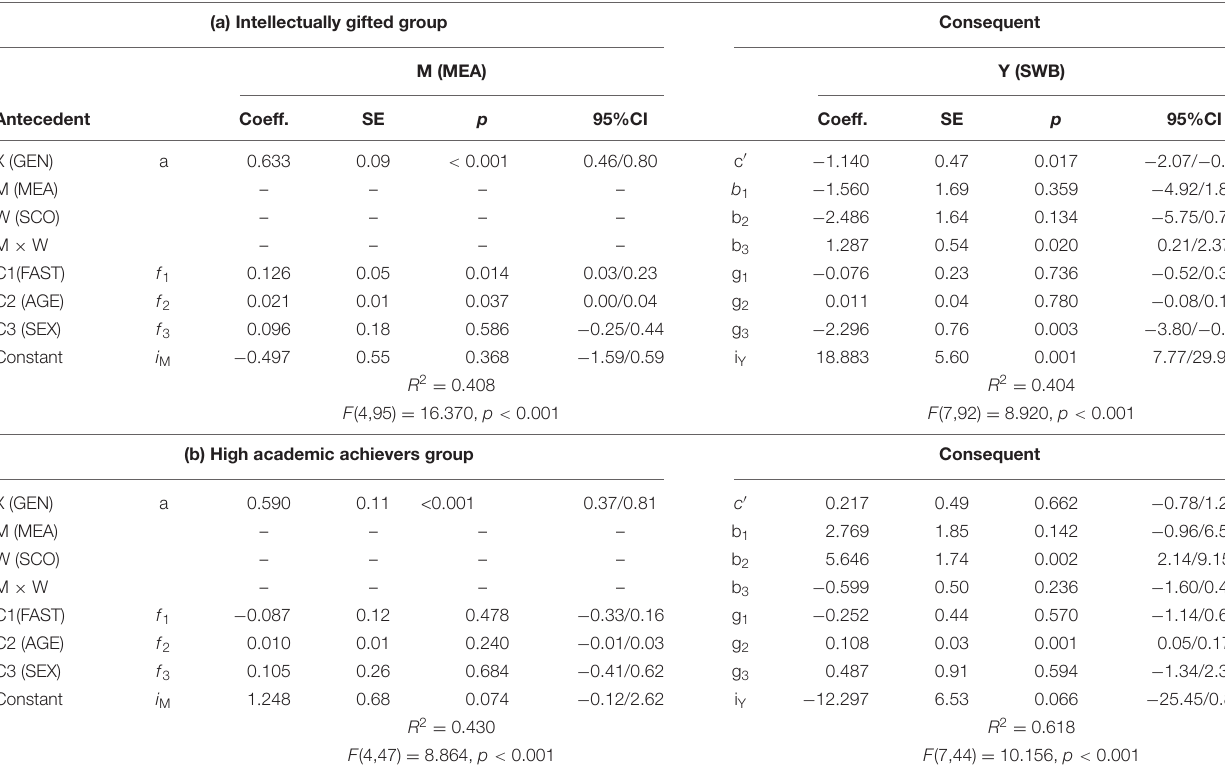
TABLE 4 | Moderated mediation model and unstandardized model coefficients among (a) intellectually gifted and (b) high academic achievers. (a) Intellectually gifted group M